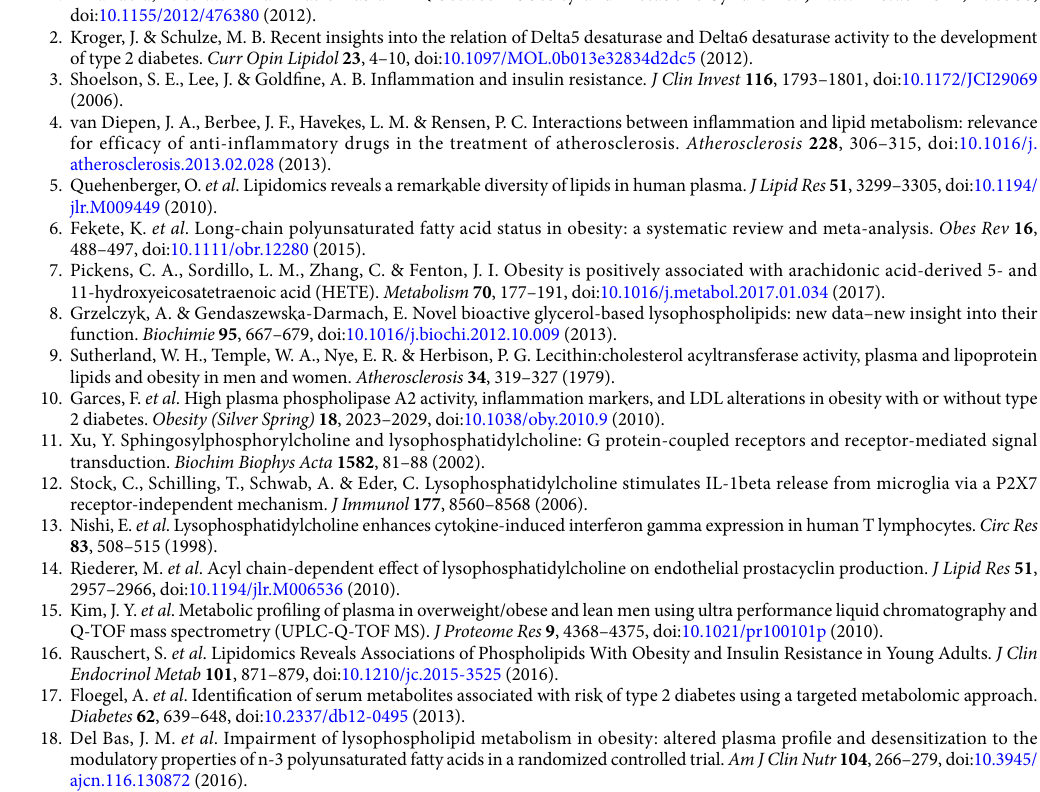
identify (TLTI). Lipid structure identification was confirmed using Lipid Maps (http://lipidmaps.org) and Human Metabolome database (http://www.hmdb.ca), and manual evaluation of MS/MS spectra. The “_” denotation is used between FAs in glyceroPL structures, since the FA position (i.e., either sn1 and sn2) were not